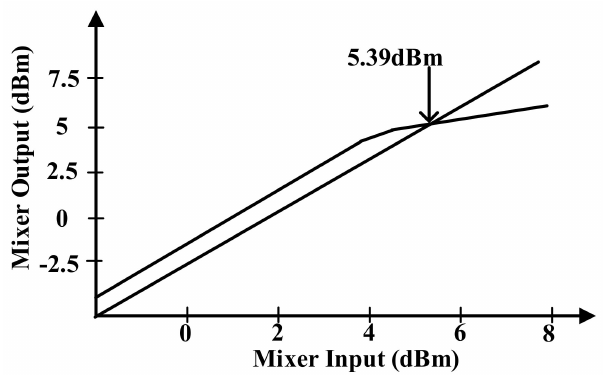
Figure 12. P1dB simulation of transmitter